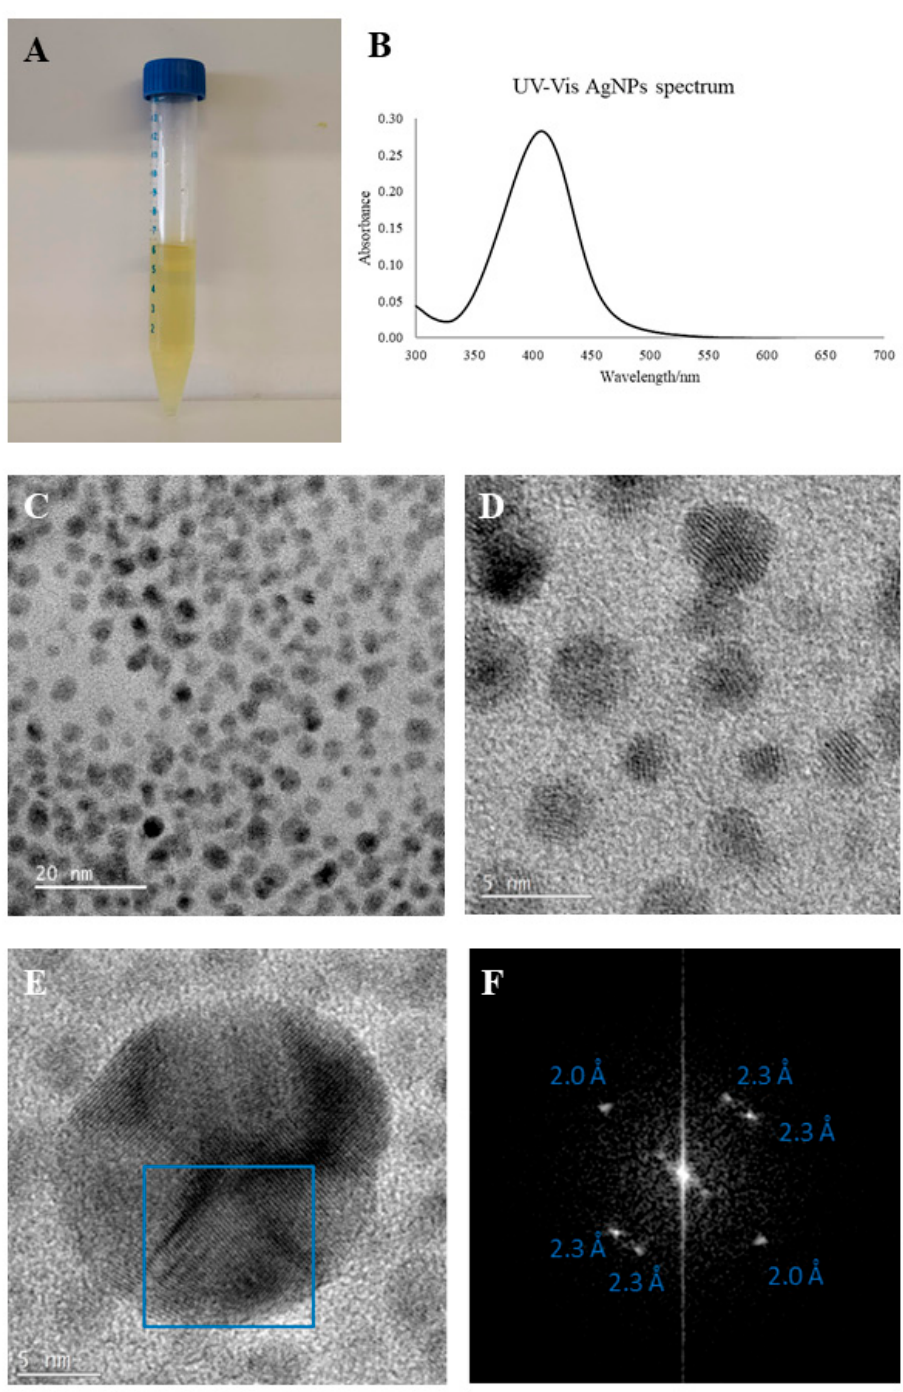
Figure 1. ( A ) Photograph of starch capped AgNPs’ suspension; ( B ) UV-Vis spectrum of starch capped AgNPs’ suspension; ( C ) TEM image of AgNPs (20 nm resolution); ( D ) TEM image of AgNPs (5 nm resolution); ( E ) HRTEM image of AgNPs; ( F ) FFT from the blue box in Figure 1E showing spacings of ~2.3 and ~2.0 A.